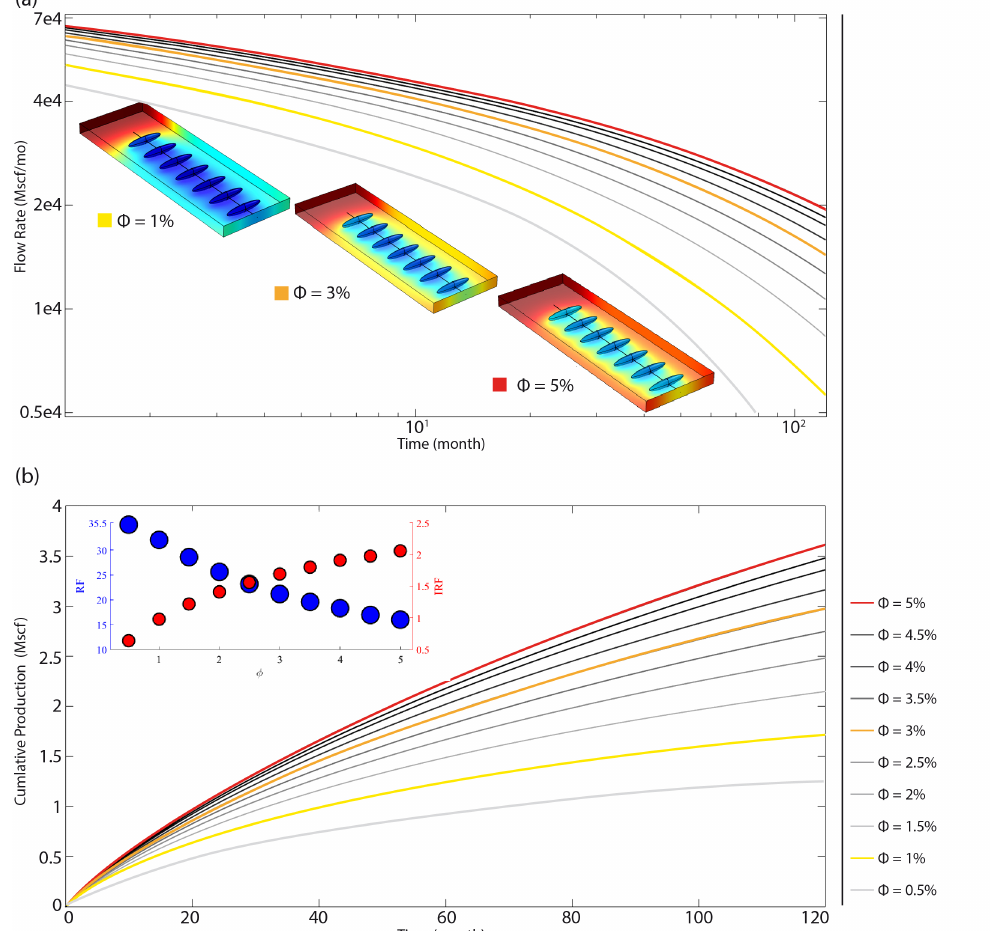
Figure 5. Impact of porosity. Flow rate production of methane in log-log scale. The snapshots represent the BCa field pressure for different porosity values ( a ). Cumulative production of methane in log-log scale ( b ). Ten year simulation. Field pressure colormap takes the value range that appears in the Figure 2g–l. In the inset of this Figure, “red dots” (IRF) have been represented smaller than “blue dots” (RF) to avoid graphic intersections between both